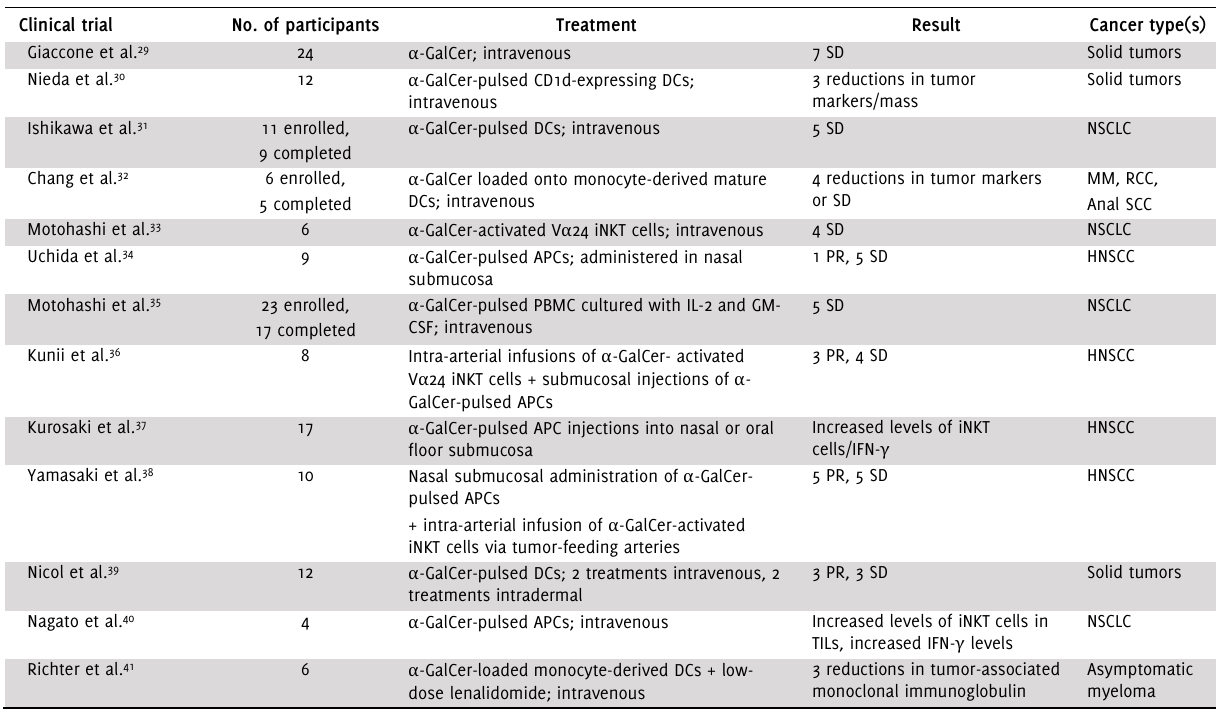
Table 1 . Clinical Trials Evaluating α -GalCer-Mediated Stimulation of iNKT Cells Clinical